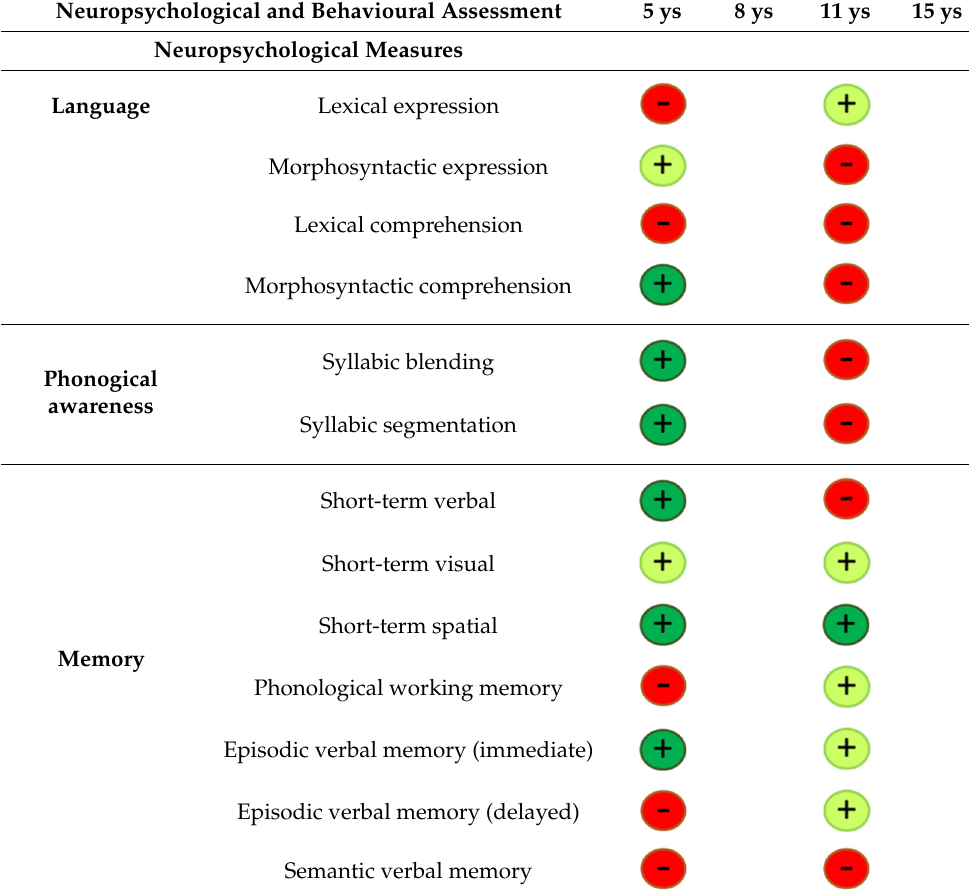
Table 2. Summary of the girl’s developmental clinical outcome in the neuropsychological, adaptive and psychopathological domains. For neuropsychological and adaptive domains, the dark green indicates preserved abilities for chronological age, whereas light green indicates preserved abilities for mental age; finally, red indicates impaired abilities for both chronological and mental age. For the psychopathological domain, light green indicates symptoms or traits not fully meeting criteria for a diagnosis (subthreshold symptoms) based on the clinical judgement, supported by K-SADS interview and CBCL